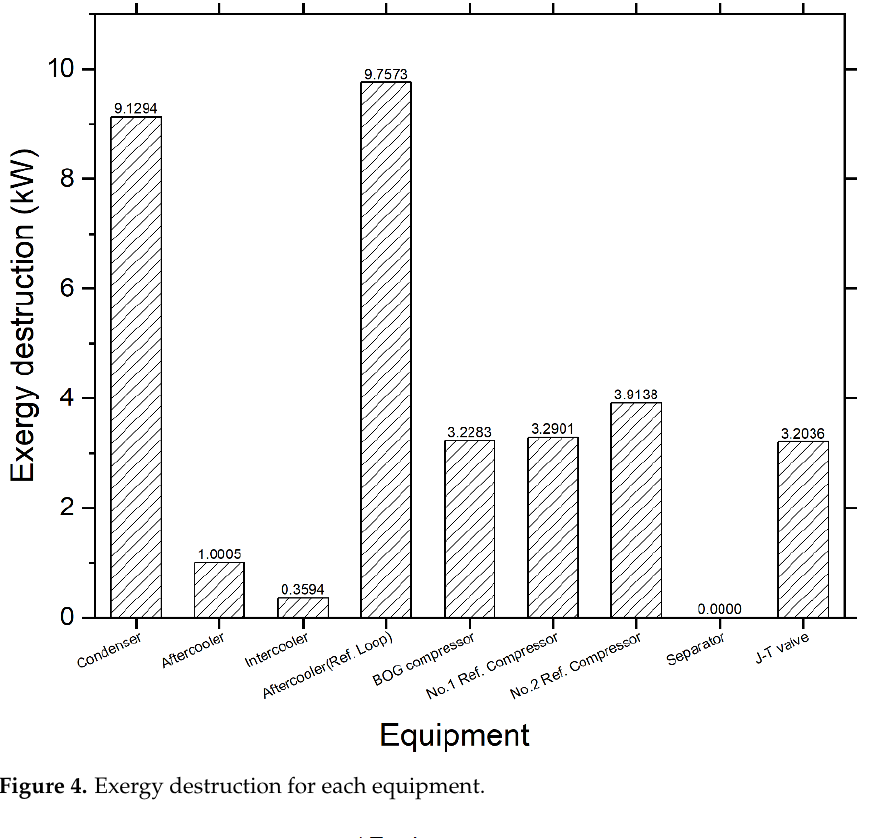
Figure 4. Exergy destruction for each equipment.